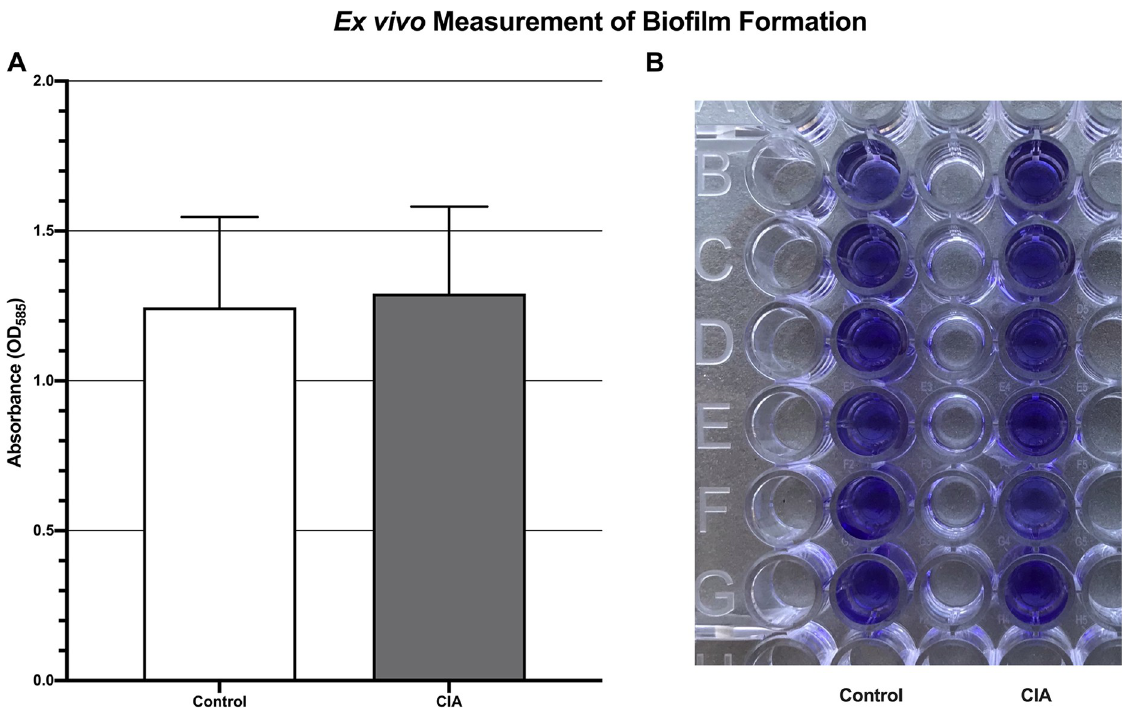
Fig 4. Ex vivo quantification of biofilm formation demonstrating no significant difference in S . aureus Xen36 burden between the blood of mice with CIA and control mice (A). This was measured by absorbance after staining of residual biofilm with crystal violet (B) (p = 0.96).